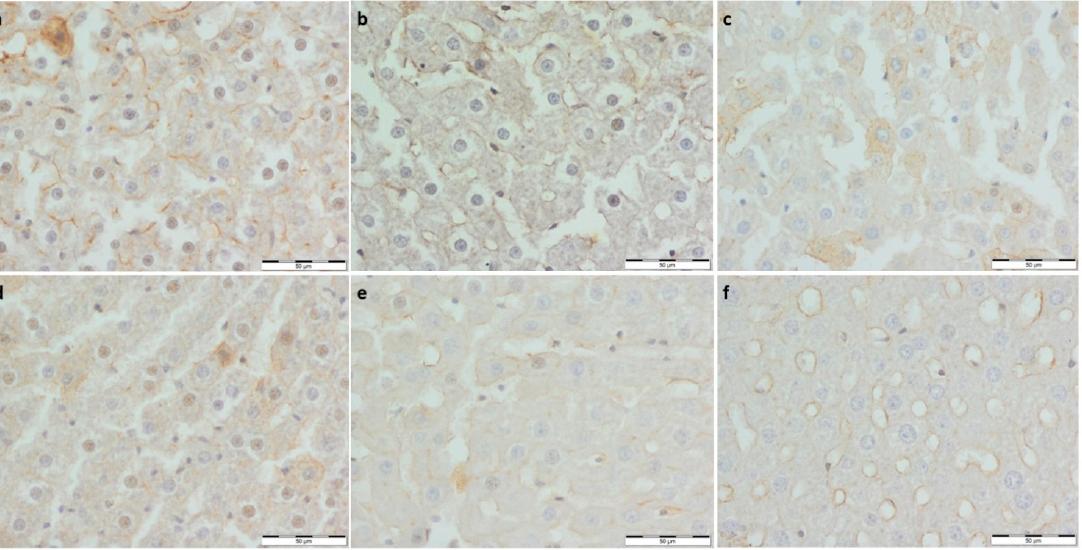
Figure 5. ( a ) Con-Sed, ( b ) Con-Run, ( c ) WP-Sed, ( d ) BP-Sed, ( e ) WP-Run and ( f ) BP-Run; immuno- stainings against nNOS (NOS1); nNOS expression was lower in all experimental groups and Con-Run comparatively to the Con-Sed group.